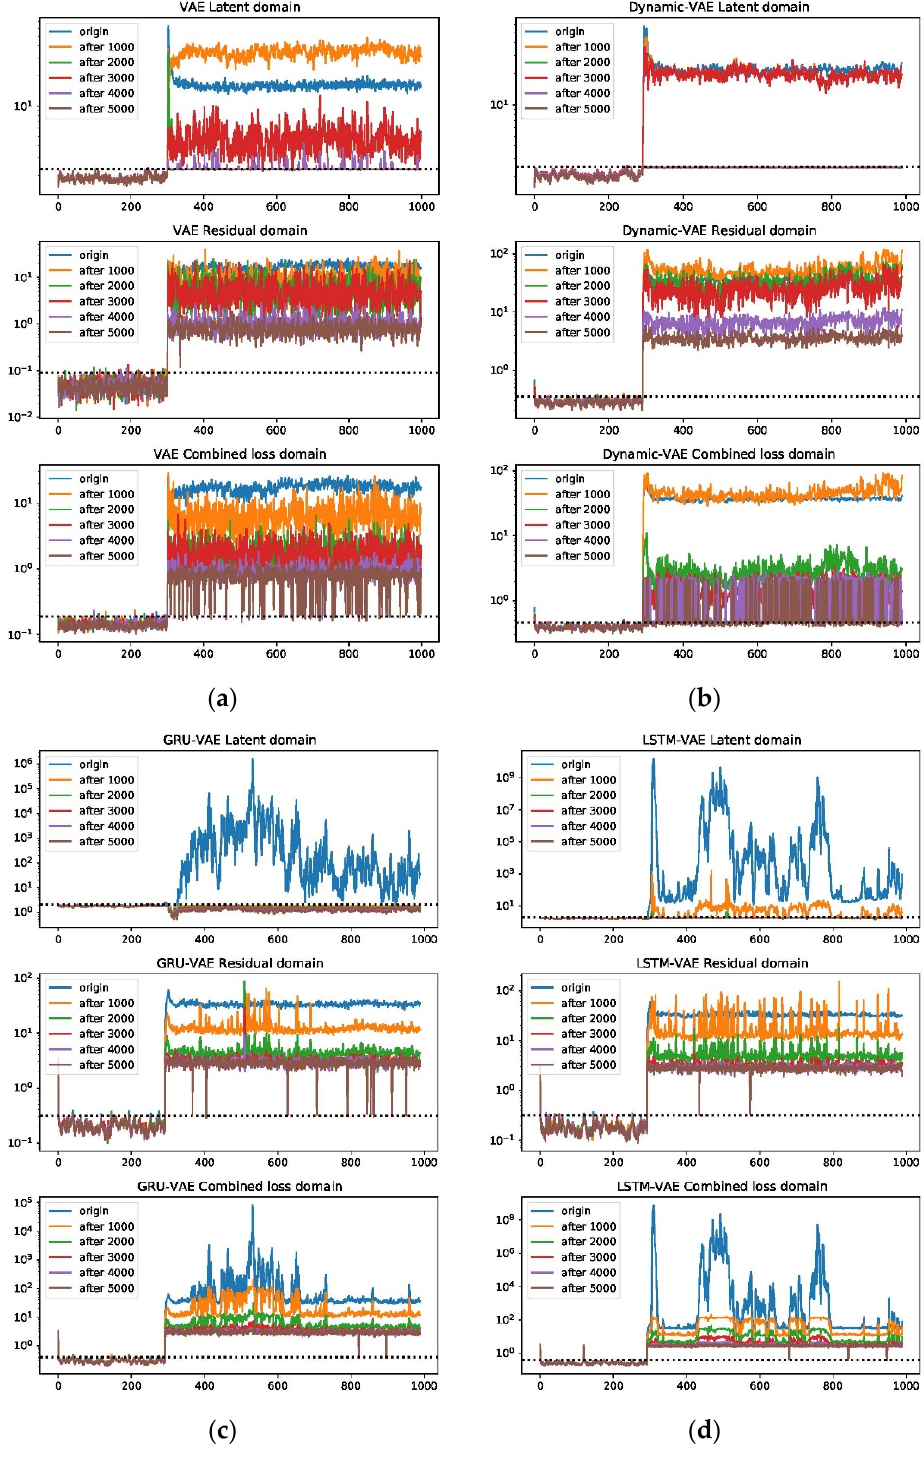
Figure 12. Combined, latent, and residue domain loss plots of VAE ( a ), Dynamic-VAE ( b ), GRU-VAE ( c ), and LSTM-VAE ( d ), with respect to 1000, 2000, 3000, 4000, and 5000 epochs on fault For large faults, even 5000 steps can only lead to an approximated estimation. This should be originated from the fact that the gradient values are very small during each iteration, which, in turn, may lead the optimizer to get stuck easily into the local maximum when disentangling the large fault. Nevertheless, compared with PCA and deep CP, which may yield inappropriate conclusions, the deep RBC can achieve results with more refined and desirable diagnosis charts. Ultimately, we can conclude here that the deep